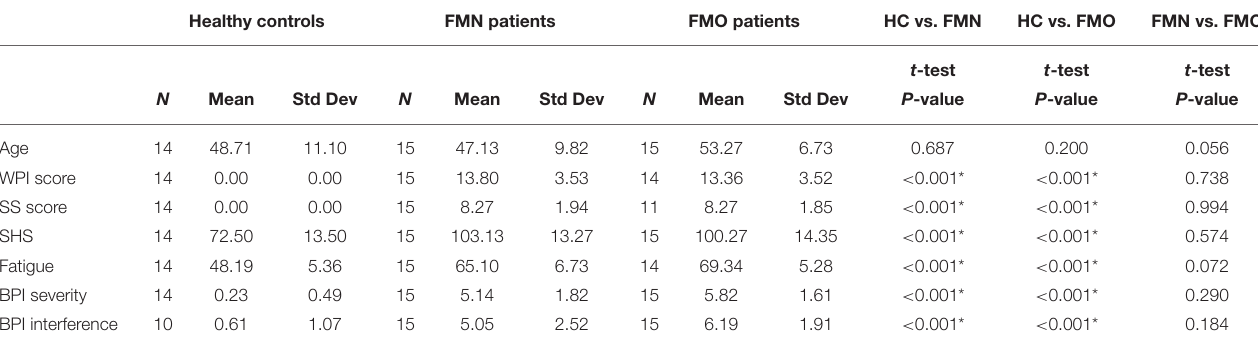
TABLE 1 | Demographic and clinical symptom measures are shown for each group with three group t -test comparisons between groups. Healthy controls FMN patients FMO patients HC vs. FMN HC vs.